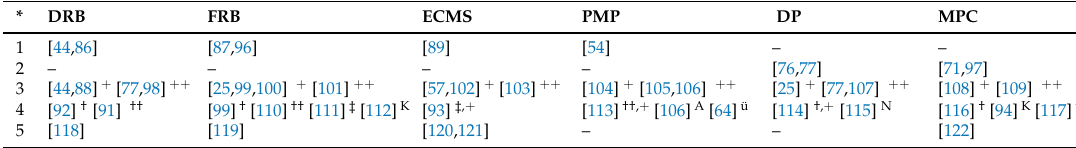
Table 2. Integration of subsidiary tools to real-time optimal power management